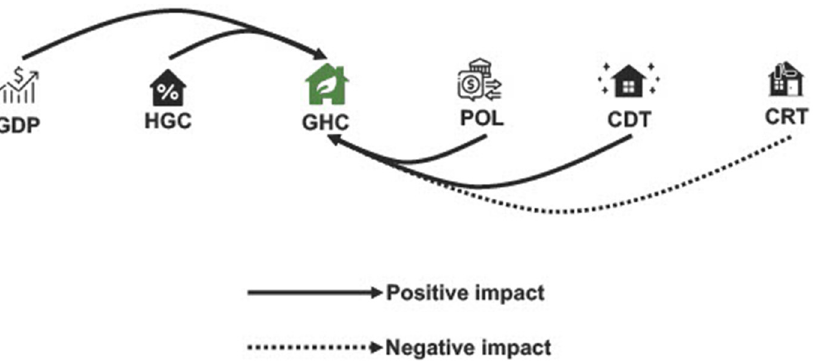
Figure 5. Summary of the variable’s effect. The authors created this figure.